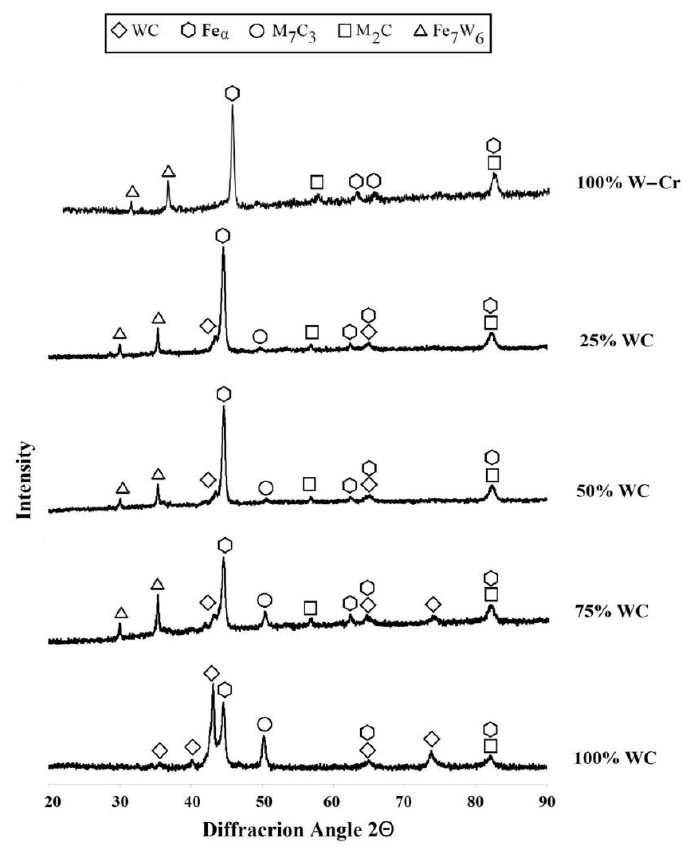
Figure 10. X-ray di ff raction of coatings reinforced using laser processing of di ff erent precoat applied Figure 10. X-ray diffraction of coatings reinforced using laser processing of different precoat applied on steel on steel substrate .